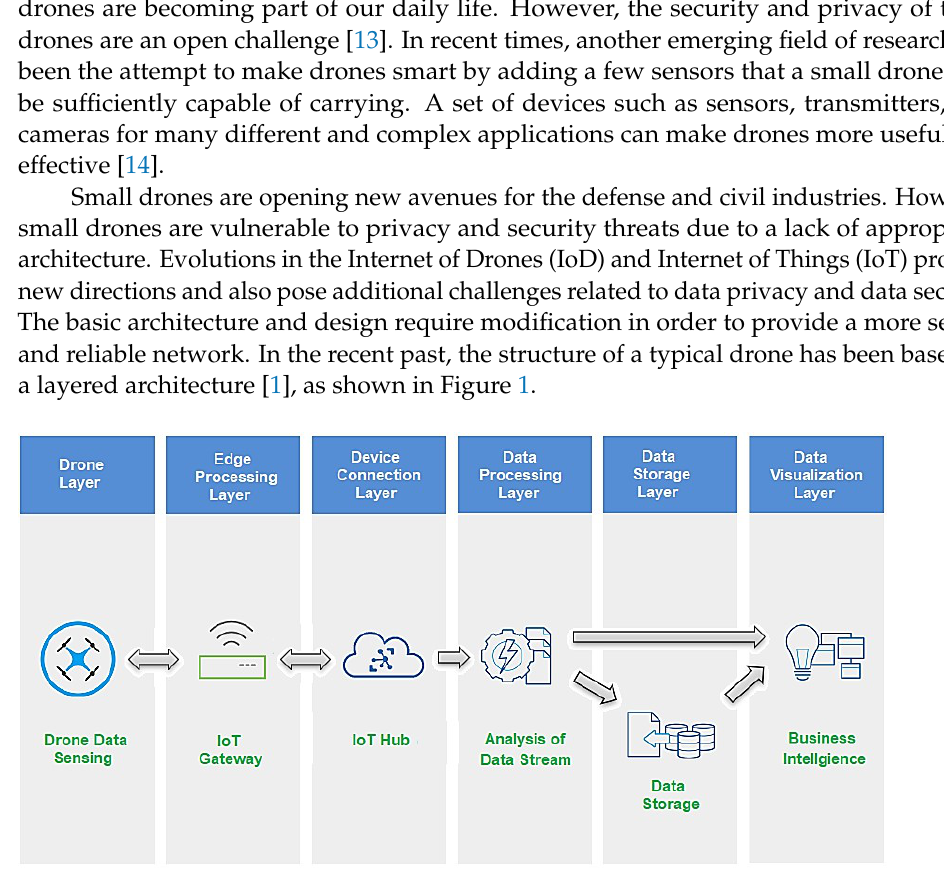
Figure 1. Layered architecture for industrial